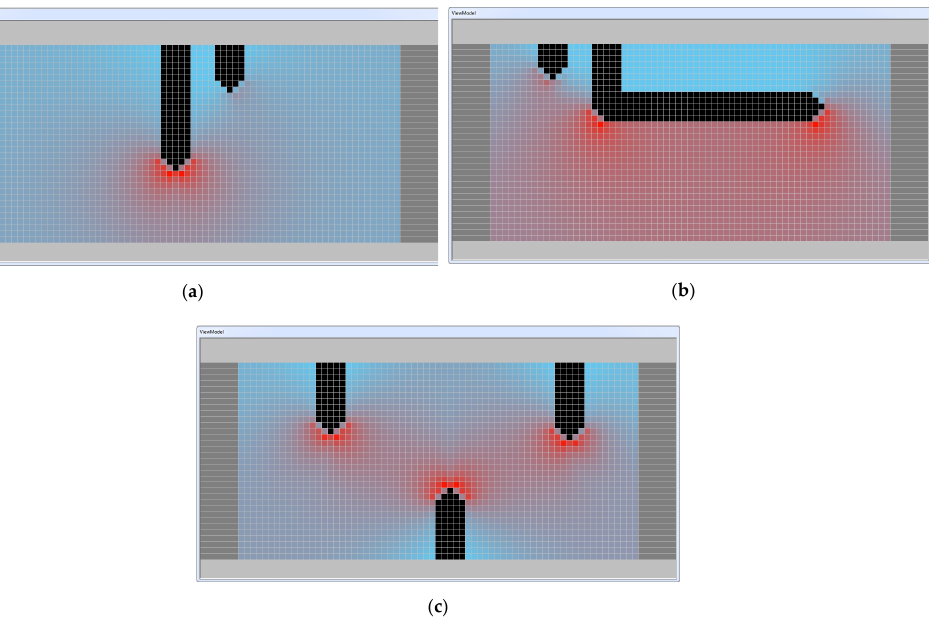
Figure 10. Current distribution for composite cut types represented as a gradient fill: ( a ) Ii ‐ cut; ( b ) Li ‐ cut; ( c ) W ‐ cut. The current is close to zero in the areas of the resistive film adjacent to the trim cut starting points. The path corners, where the laser beam changes its direction, envelope the converging current lines. It results in high currents and powers at the adjacent ERs. For the I ‐ cut (Figure 9a), the so ‐ called “hot spot” is at the end of the path. For this path, the current power at the branches is the highest among all the other cut types. The L ‐ , J ‐ , U ‐ , and S ‐ cuts (Figure 9b–e) have two hot spots at each of the path corners. The resistive film segment adjacent to the second leg of the paths is slightly less loaded. This is because the current lines coming from the trimmed contact area of the conductive and resistive layers and going around the cut path corners are redistributed across the remain ‐ ing width of the resistor. Let us now simulate the L ‐ cut trim with the parameters listed in Table 9 except for the node size: it is set to 12 μ m instead of 6 μ m. The initial current distribution across the ERs is shown in Figure 11. The current passing through the horizontal ERs is the same and approximately equal to 0.368 mA (for clarity, the displayed current values in this ex ‐ ample are multiplied by 10). There is no current passing through the vertically oriented resistors. After the trim, the current lines are distorted around the path corners and tend to be evenly distributed over the area between the second leg of the cut and the edge of the resistor (see Figure 12). The arrows show the current directions. The currents at the grid branches are shown in Figure 13.